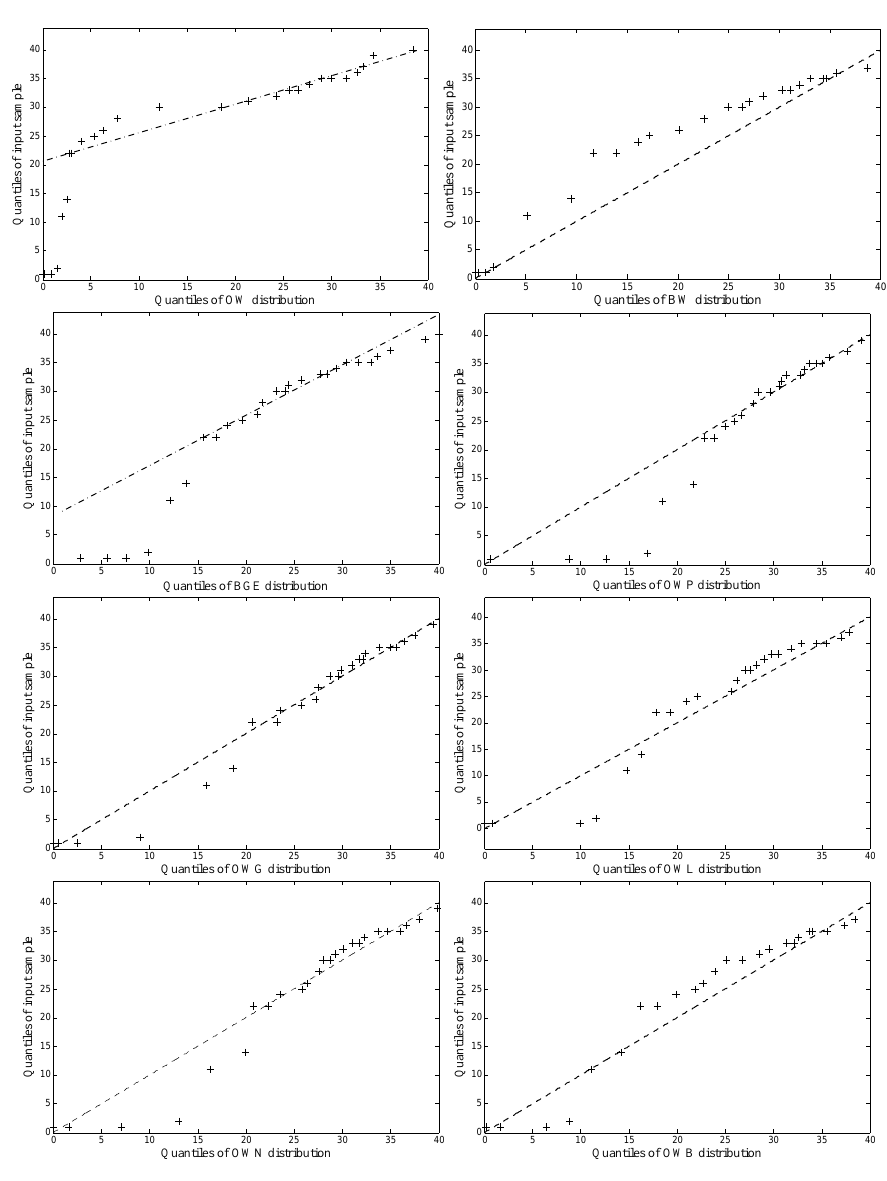
Figure 6 – Quantile-quantile plots for the fitted distributions for the second data